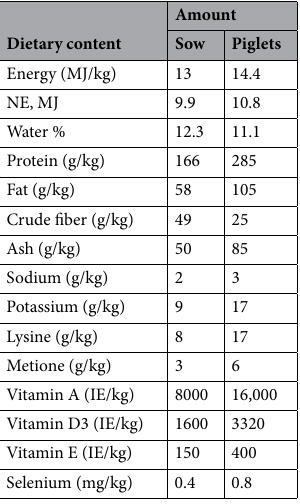
Table 2. Dietary content for sows and